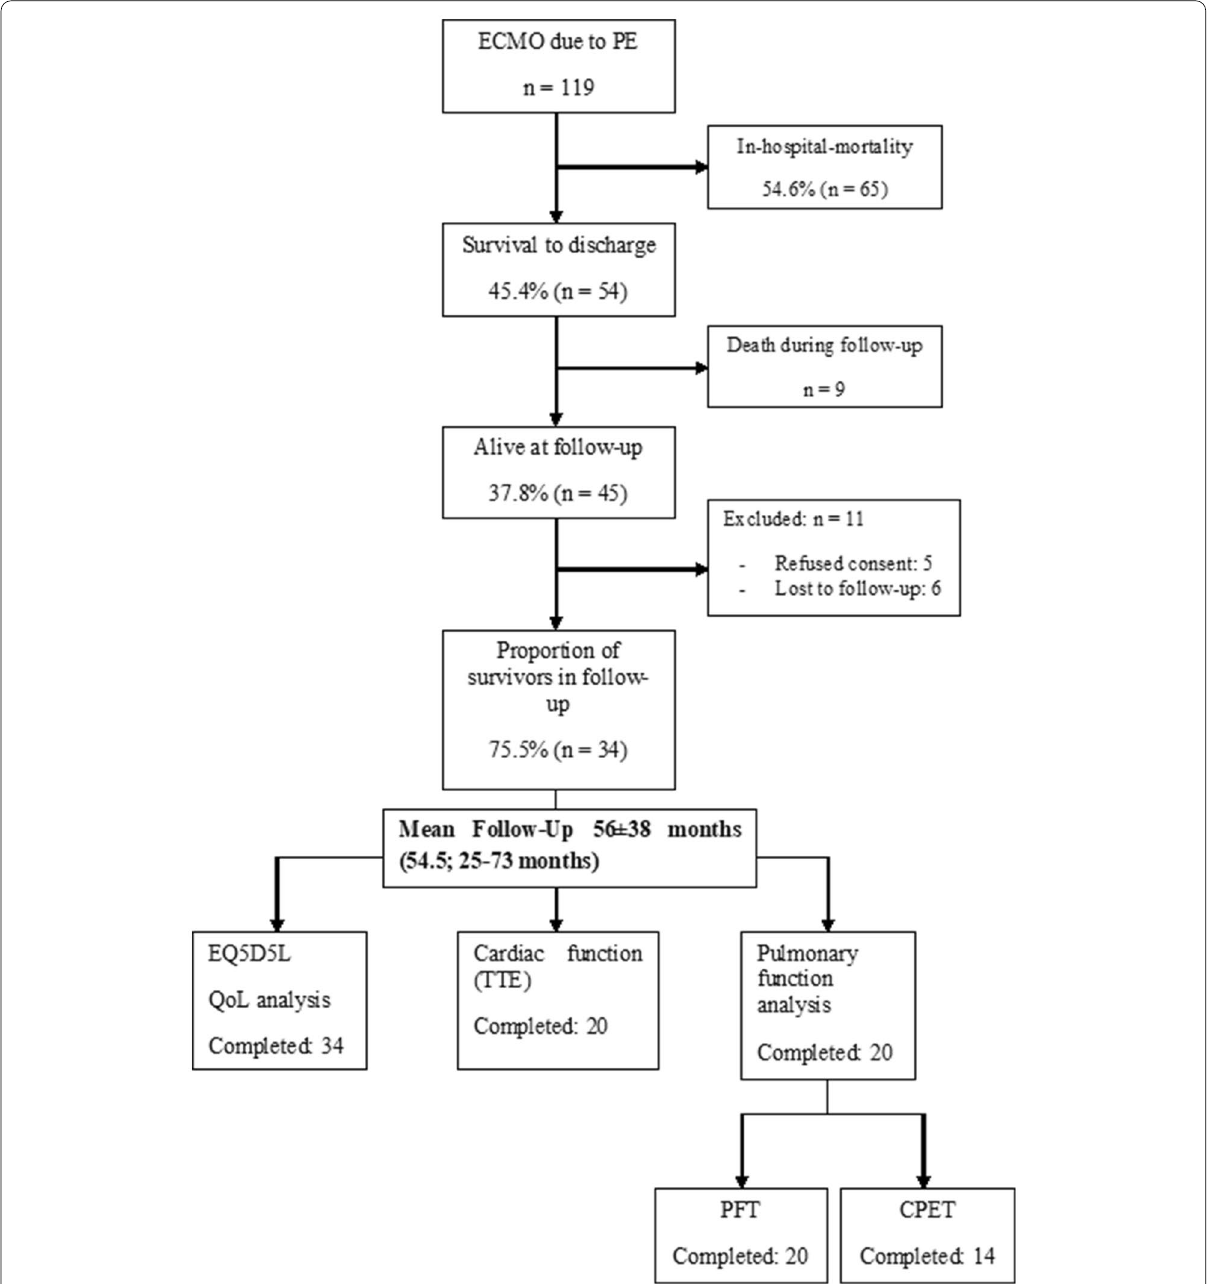
Fig. 2 Flowchart of the recruitment and follow-up process. Figure 2 depicts the follow-up process from onset of the disease until